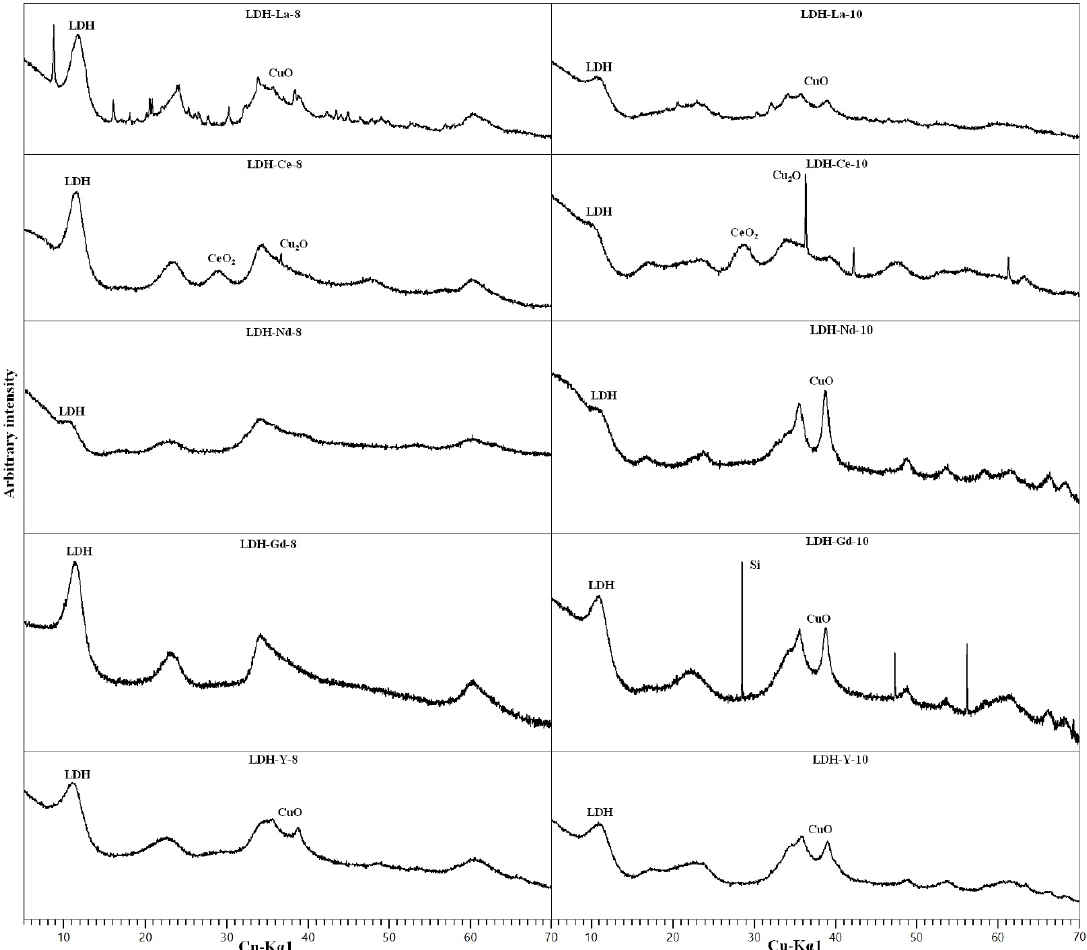
Figure 7. PXRD patterns of REEs-doped samples. Only the main maximum for every phase is labelled.